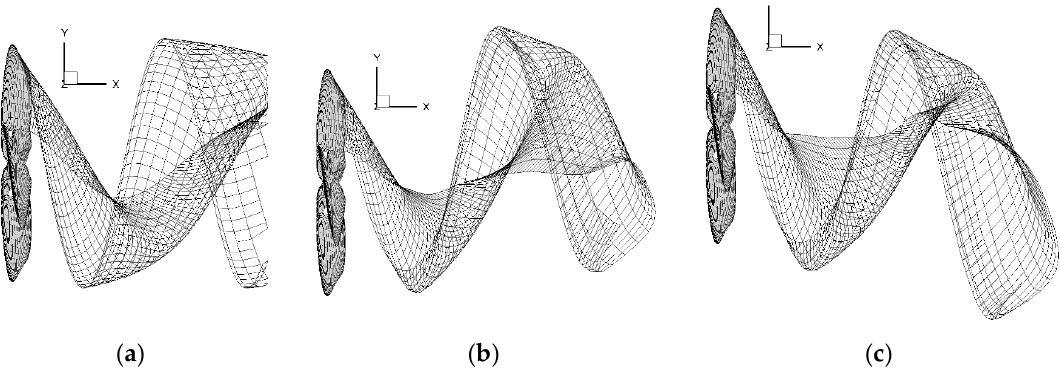
Figure 10. Comparison of steady wake geometry and unsteady blade wake geometries at different blade angles. The blade-angle ranges between 0 and 2 π and is defined by the angle the blade has passed starting from the “upright position”. The “upright position” means the mid-camber point of the root section is located on the vertical axis above the hub (+ y axis). ( a ) steady wake; ( b ) unsteady wake 0 degrees; ( c ) unsteady wake 180 degrees. Please note the wake is shown relative to the propeller fixed system. So the hull is physicallly located above the propeller in ( b ), but “below” the propeller in ( c ). Thus, in both cases, ( b ) and ( c ), the propeller wake appears to be aligned in a direction parallel to the hull surface.